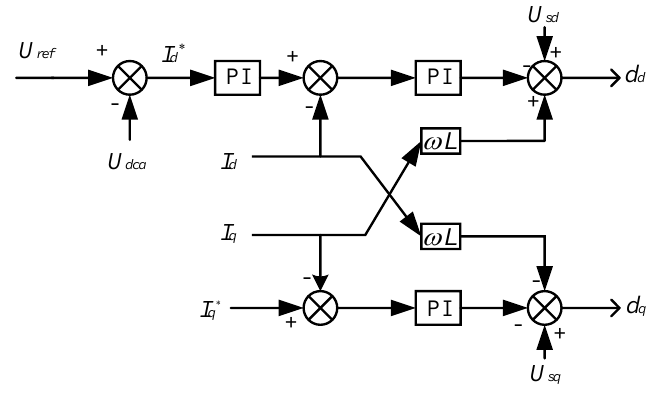
Figure 2. Current DQ decoupled double closed-loop control.